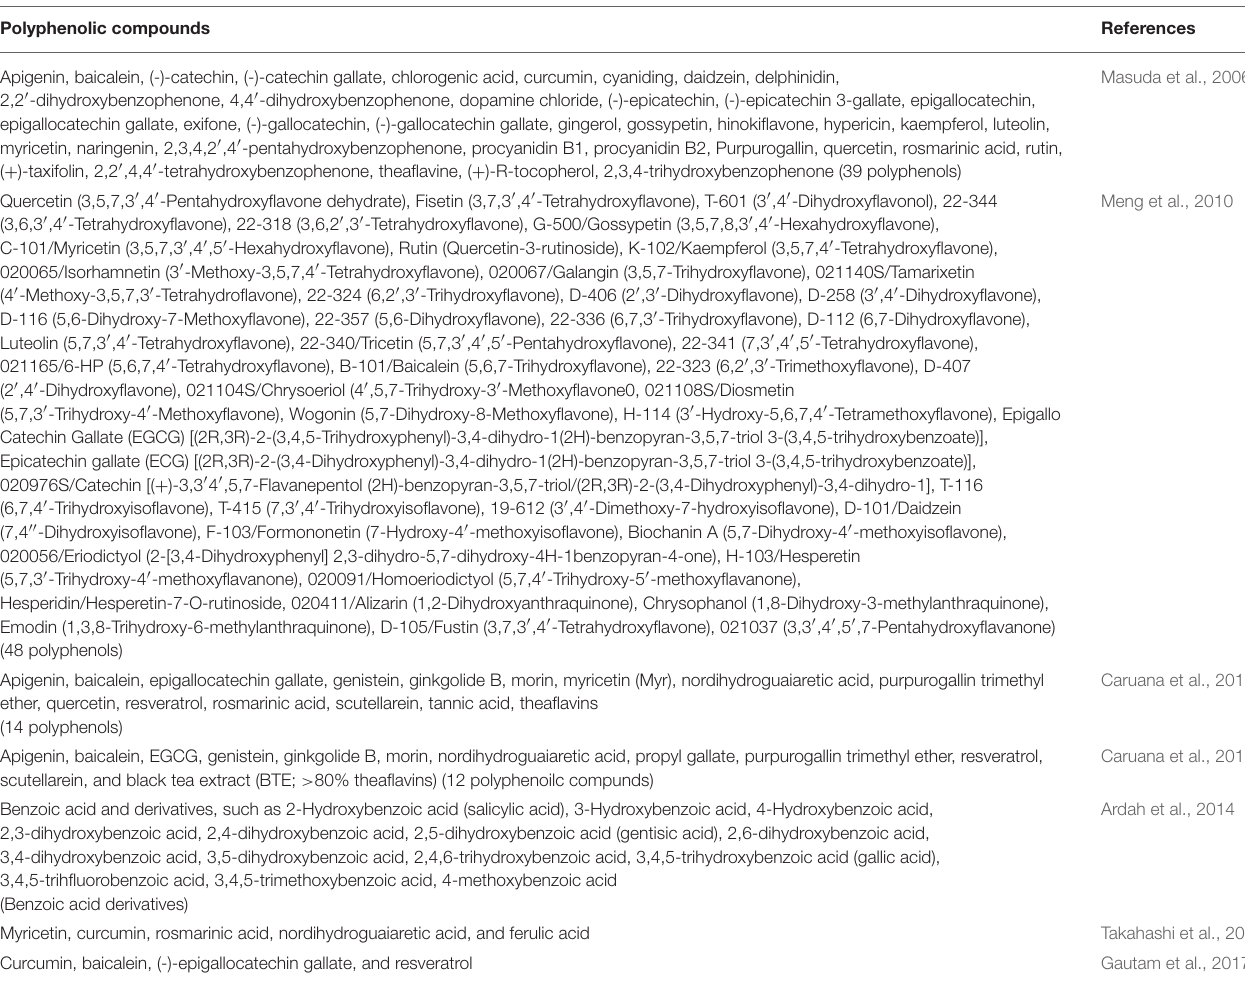
TABLE 5 | The polyphenol compounds investigated for their action on α -synuclein fibrillation, aggregation, and cytotoxicity. Polyphenolic